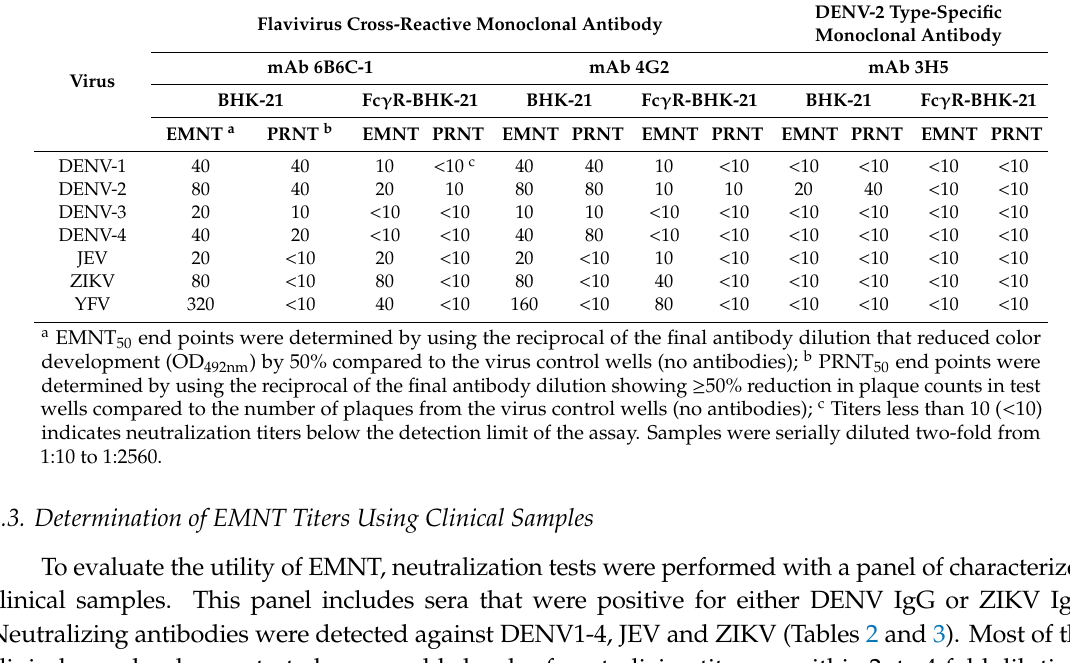
Table 1. Neutralizing Titers of Anti-E Monoclonal Antibodies (EMNT 50 vs. PRNT 50 ) to DENV, JEV, ZIKV and YFV Using BHK-21 and Fc γ RIIA-Expressing BHK-21 as Assay Cells.